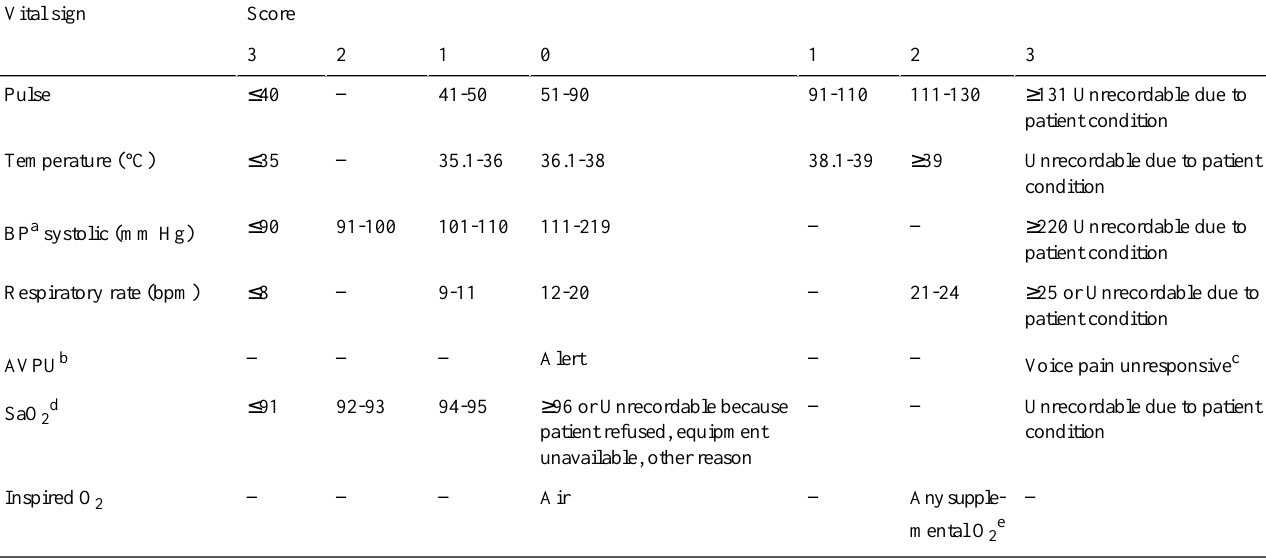
Table 1. Escalation protocol for the deteriorating patient